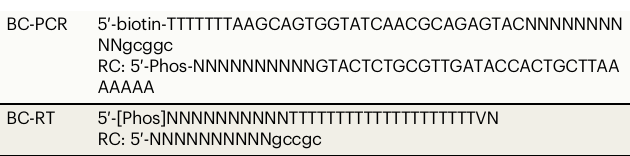
Table 2 | Sequences used in the barcode fragments BC-PCR 5 ′ -biotin-TTTTTTTAAGCAGTGGTATCAACGCAGAGTACNNNNNNNN NNgcggc RC: 5 ′ -Phos-NNNNNNNNNNGTACTCTGCGTTGATACCACTGCTTAA AAAAA BC-RT 5 ′ -[Phos]NNNNNNNNNNTTTTTTTTTTTTTTTTTTTTVN RC: 5 ′ -NNNNNNNNNNgccgc